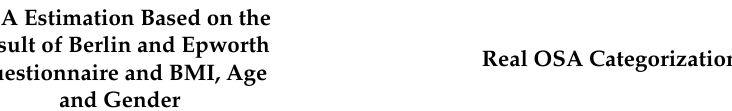
Table 12. AI prediction of OSA based on age, gender, BMI, and the Berlin and Epworth questionnaires (the table shows the number of cases per 100 patients and the percentage distribution of scores within OSA categories). OSA: obstructive sleep apnoea.